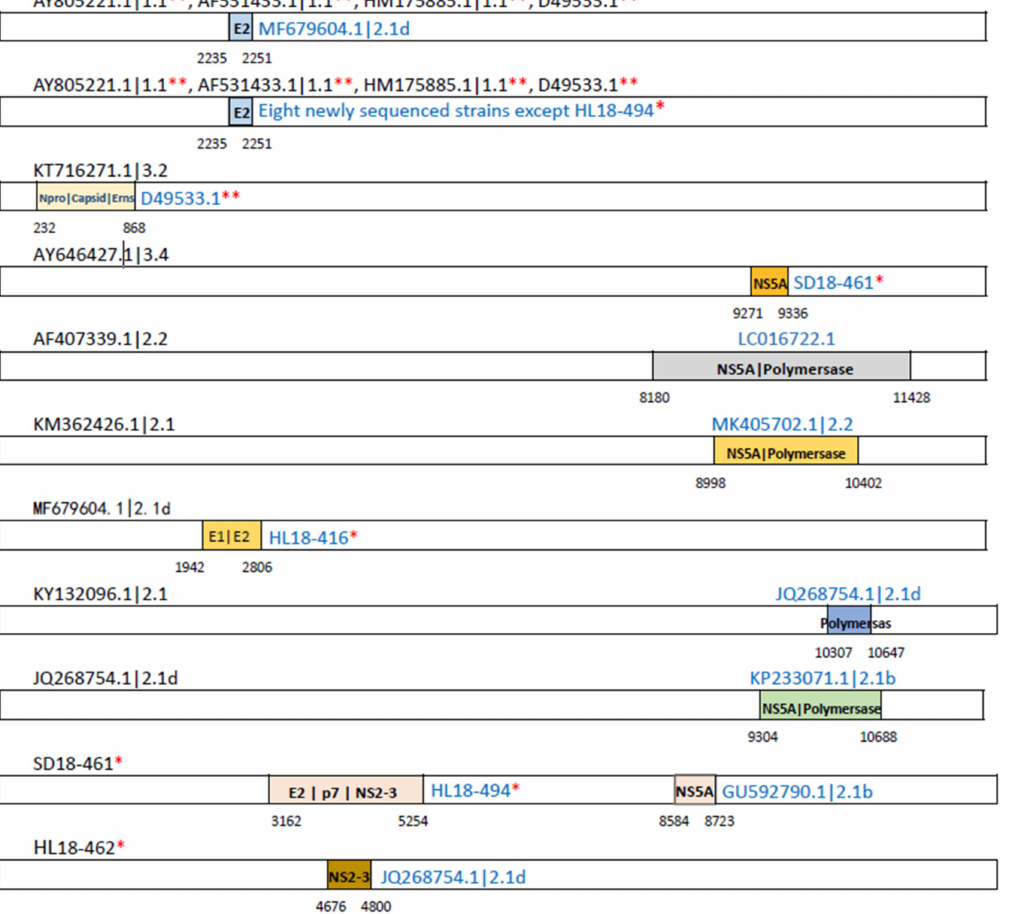
Figure 6. Schematic diagram showing the potential recombination events among different CSFV isolates. The genomic locations and breakpoints of the potential recombining segments are schematically indicated with colored frames. *, the new isolates in this study; **, C-strain